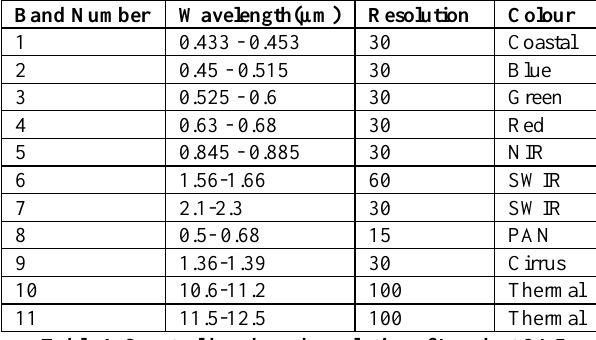
Table 1. Spectral bands and resolution of Landsat OLI.